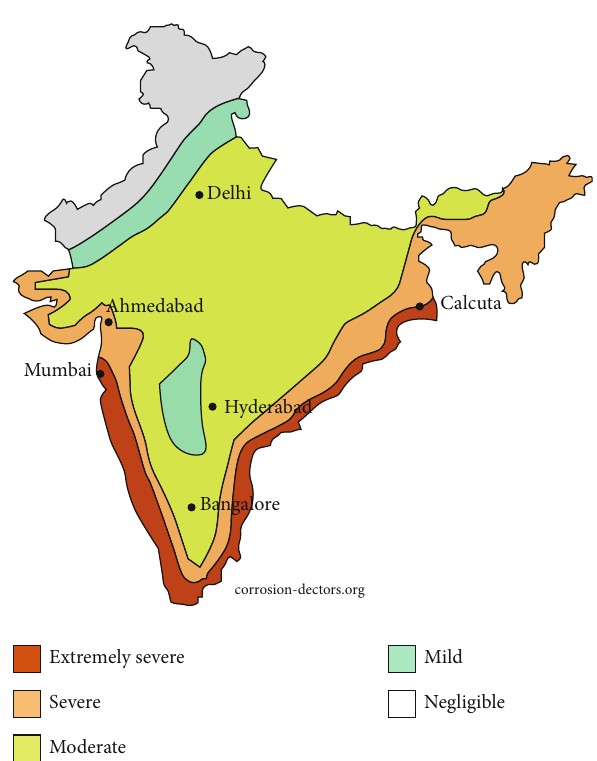
Figure 9: Atmospheric corrosion in India